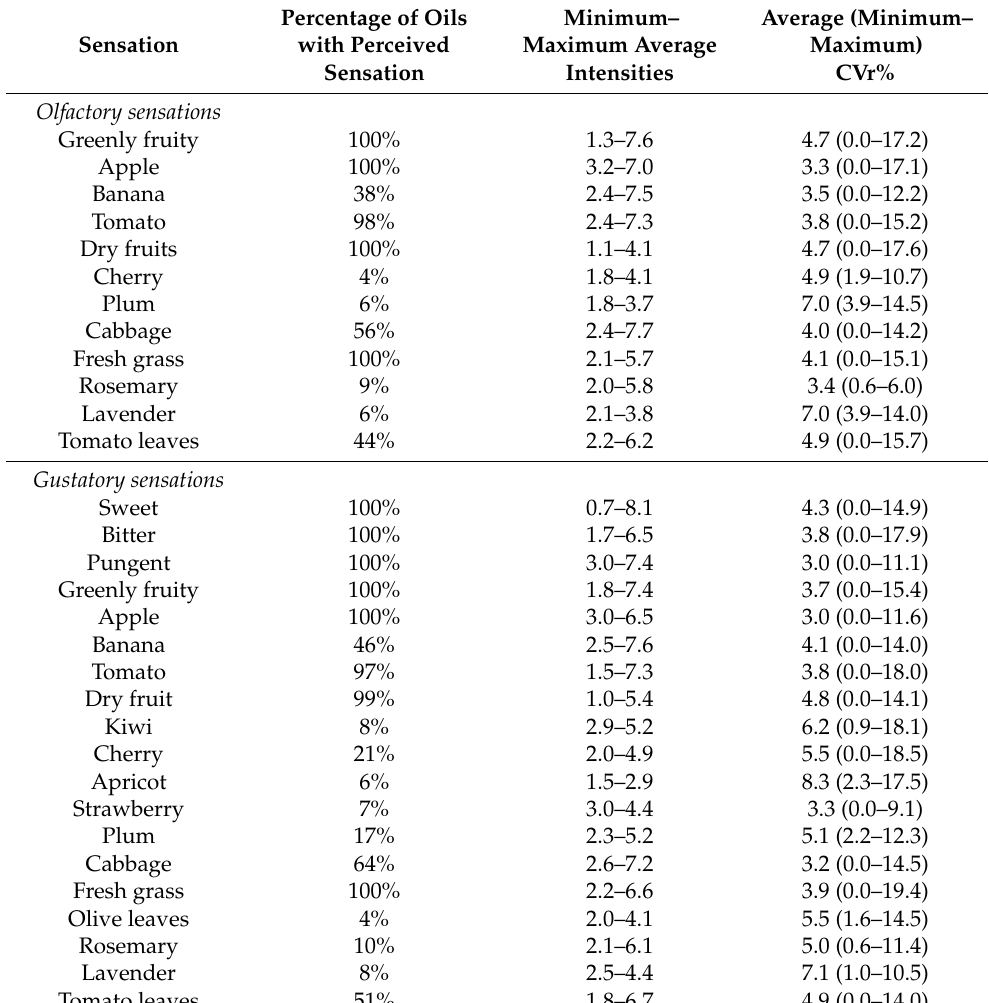
Table 1. Olfactory and gustatory sensations perceived by the sensory panel in the 96 olive oils evaluated: sensation perceived, percentage of oils for which the sensation was perceived, minimum– maximum average intensity perceived, and related average (minimum–maximum) robust coefficient of variation